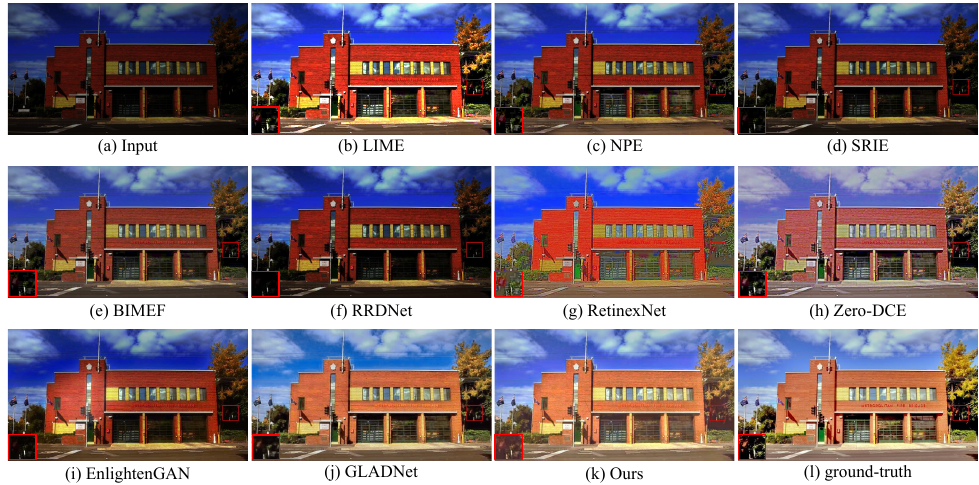
Figure 7. Visual comparisons of different methods on a real image from SICE